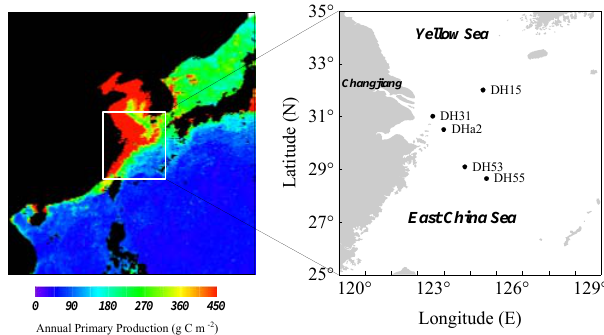
Fig. 1. Sampling locations in the East China Sea. The primary production map is from: http://marine.rutgers.edu./opp/swf/Production/gif_files/PP_Month_9806B.gif